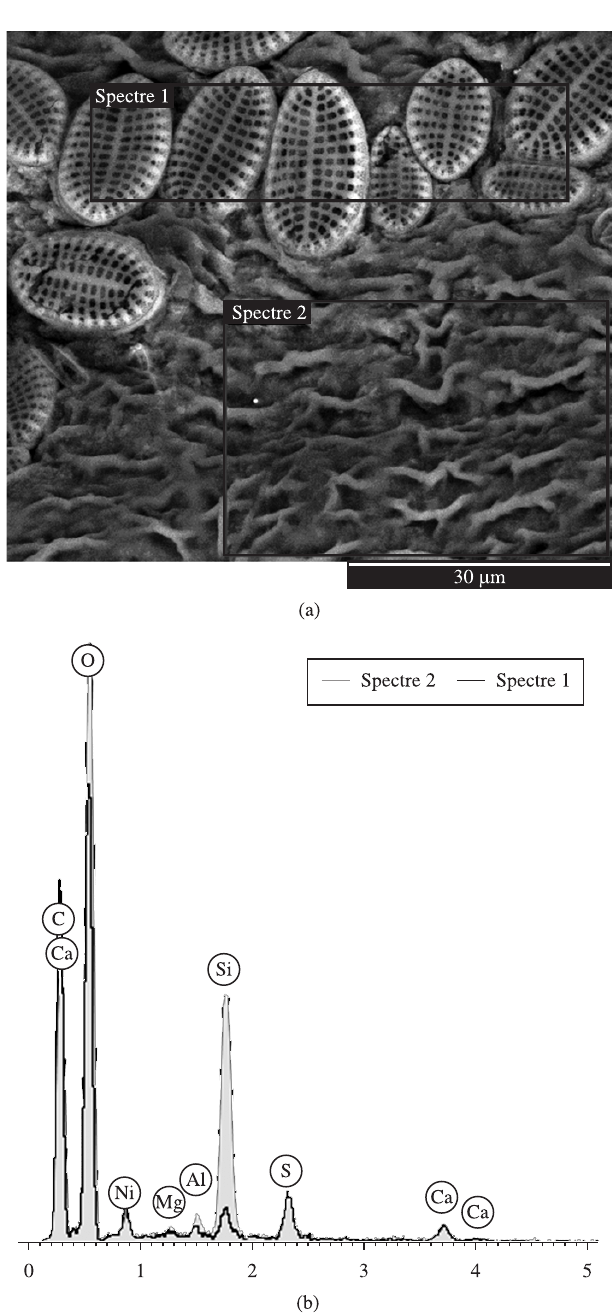
Figure 7. a) Scanning electron microscopy (SEM) micrographs of Sargassum filipendula treated pH 5.0 saturated with nickel; and b) energy dispersive X-ray spectroscopy (EDX) in the regions of spectra 1 and 2 of the